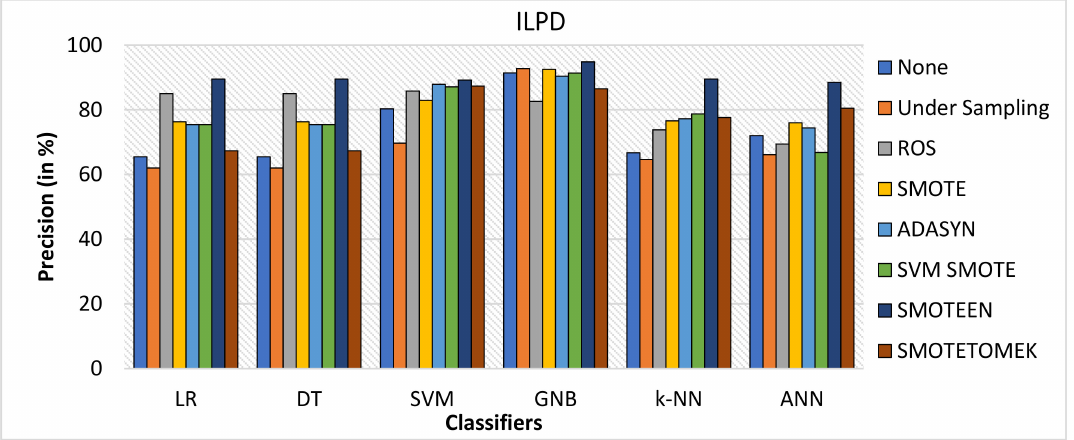
Figure 7. Precision for breast cancer disease dataset of balancing algorithms over six classifiers.